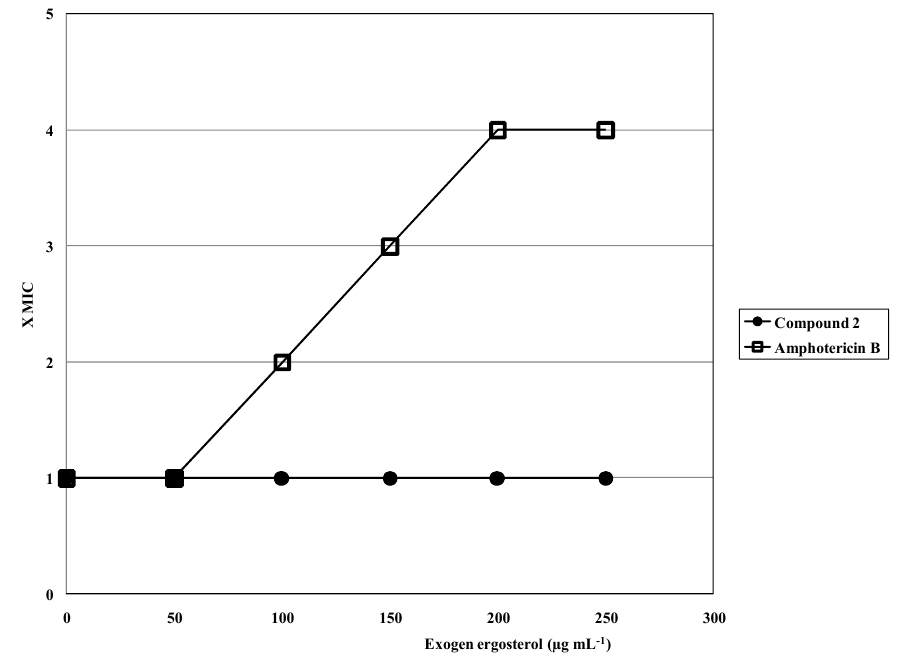
Figure 2. Effect of exogen ergosterol (50–250 µg mL − 1 ) on the MIC of both, 6-NO eugenol ( 2 ) and amphotericin B against C. albicans ATCC 10231. On the “y” axis: 1 = 1× MIC; 2 = 2× MIC; 4 = 4×